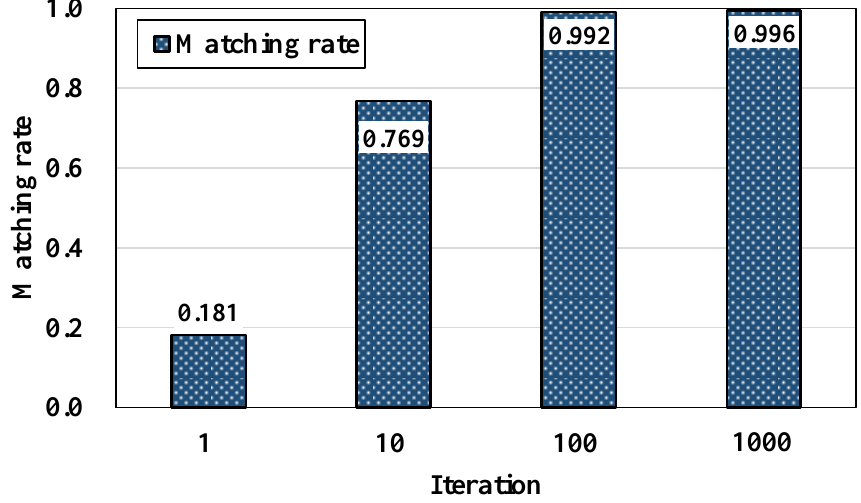
Figure 12. Matching rate review according to number of iterations.